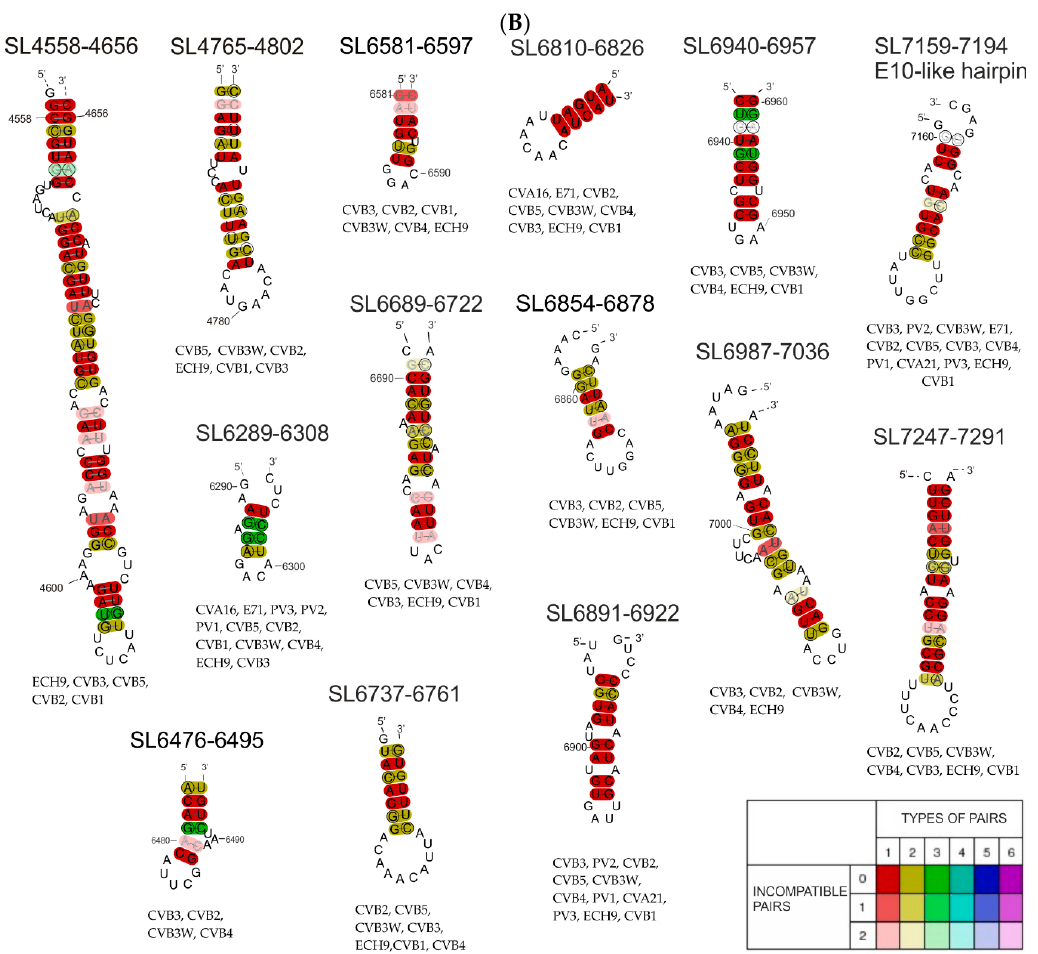
Figure 4. ( A ) Consensus secondary structures generated by the RNAalifold program for particular RNA motifs identified in the coding part of the Coxsackie B3 virus genome, the “Nancy” strain and 19 other CVB3 strains/isolates. The colors indicate structural conservation according to the key in the figure. ( B ) Consensus secondary structures generated by RNAalifold program for particular RNA motifs identified in the coding part of the Coxsackie B3 virus genome, the “Nancy” strain and some of 11 other enterovirus strains we investigated. (CVA16-U05876.1|CAU05876 coxsackievirus A16 G-10; CVA21-D00538.1 | CXA21CG Human coxsackievirus A21 (strain